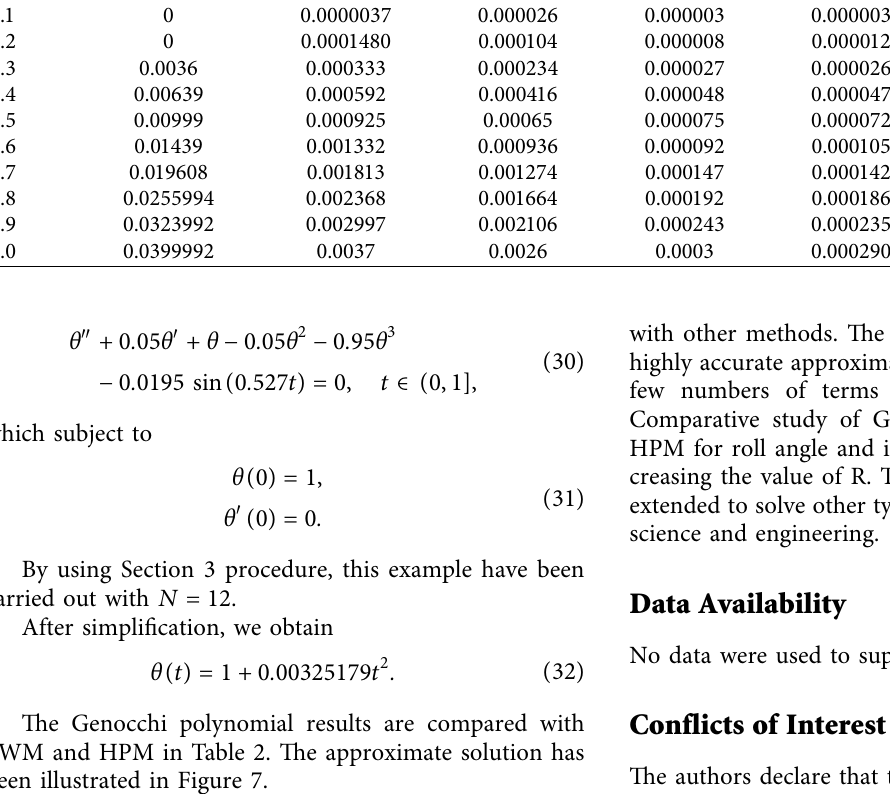
Table 3: Absolute error of Genocchi polynomial for roll angle with respect to the time t (in sec). Time